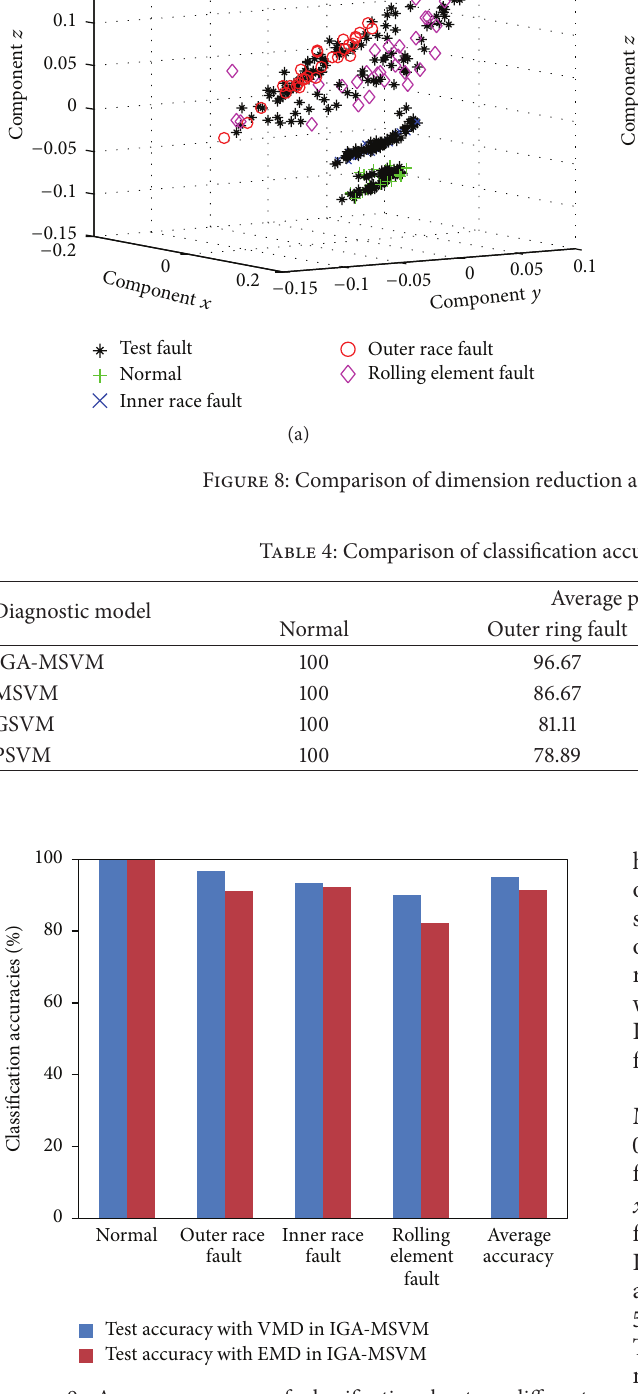
Figure 9: Average accuracy of classification by two different decomposition